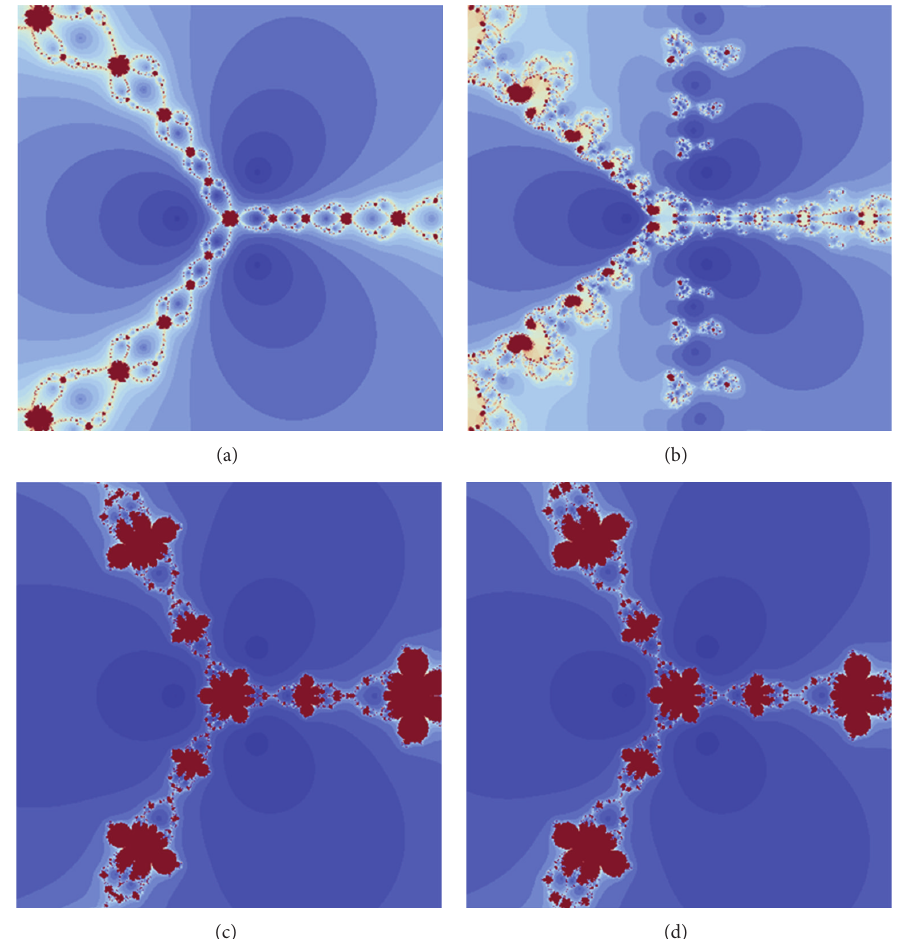
Figure 3: Fractal behavior for the rational function associated to the Steffensen’s method with 𝛽 = 0.01 (a), Jain’s method (b), (3) with 𝛽 = 0.01 (c) and (3) with 𝛽 = 0.0001 (d) for 𝑓 : 𝑧 → 𝑧 3 + 1 . Shading according to the number of iterations.